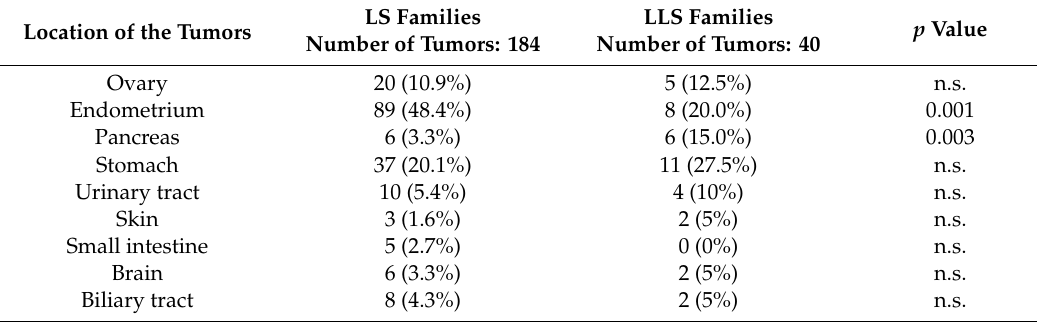
Table 3. Non-CRC LS-associated tumors in LS and LLS patients and their FDR. LS Location of the Tumors